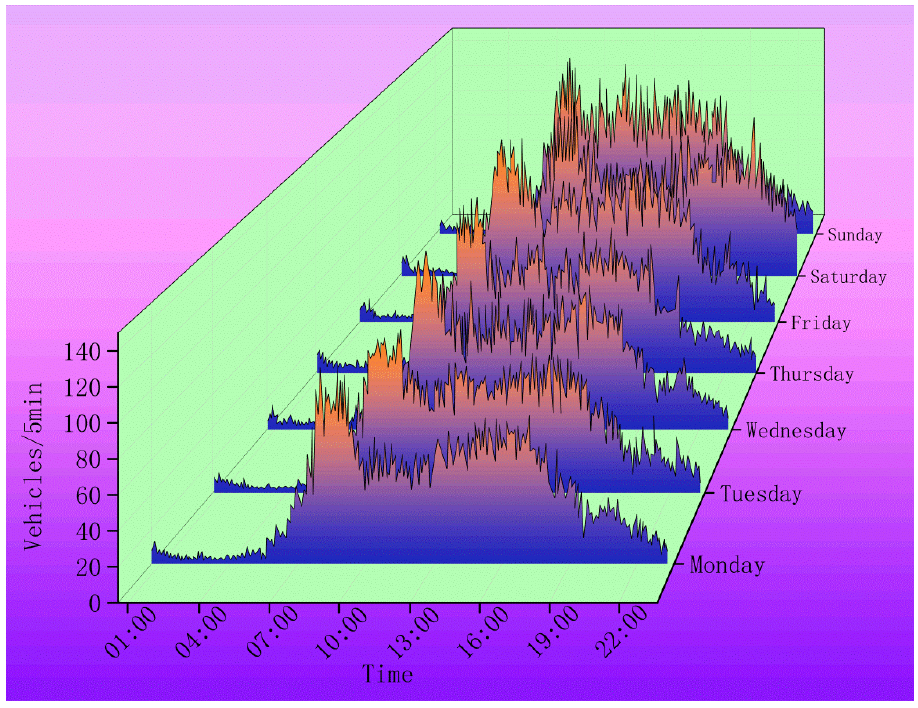
Figure 8. The predicted value in a week.